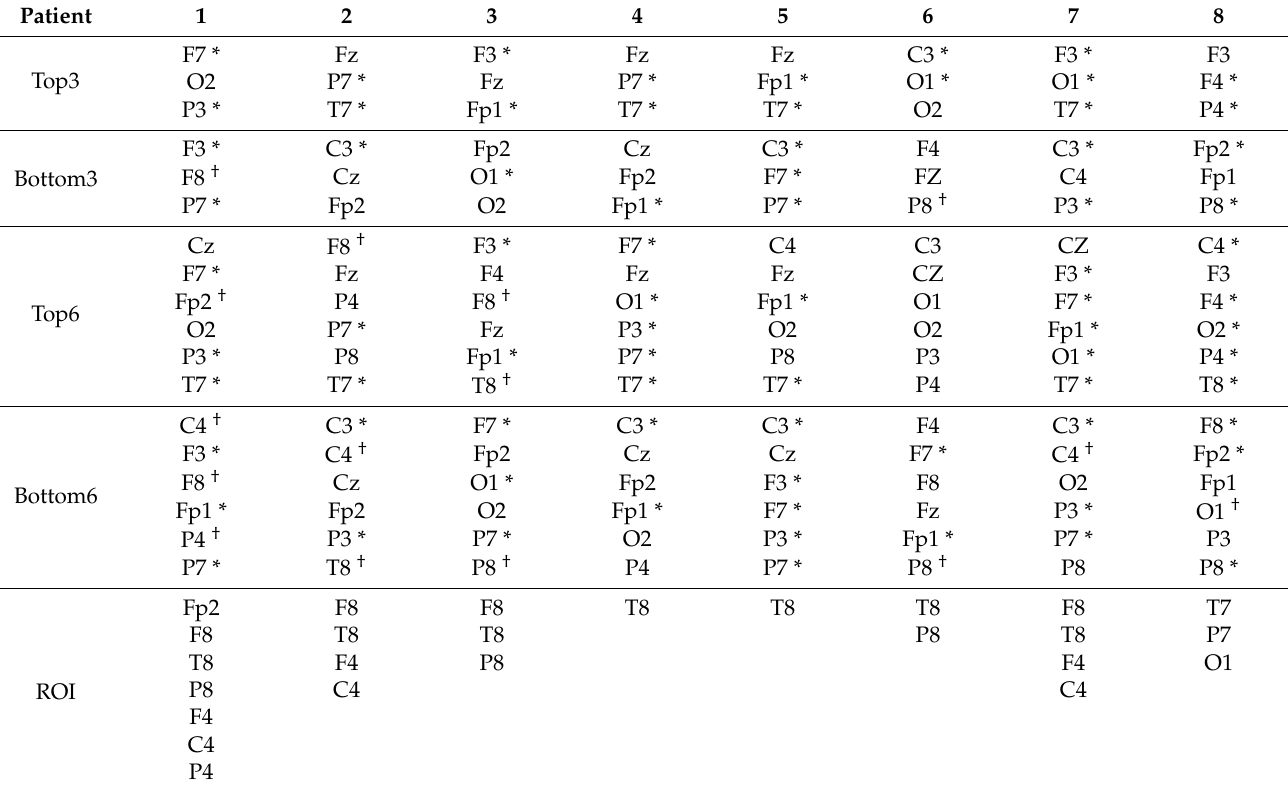
Table 6. Channels selected for each individual patient based on the attention score. The symbol * denotes channels contralateral to a region of interest (ROI) related to epileptogenic foci. The symbol † indicates channels corresponding to ROI.